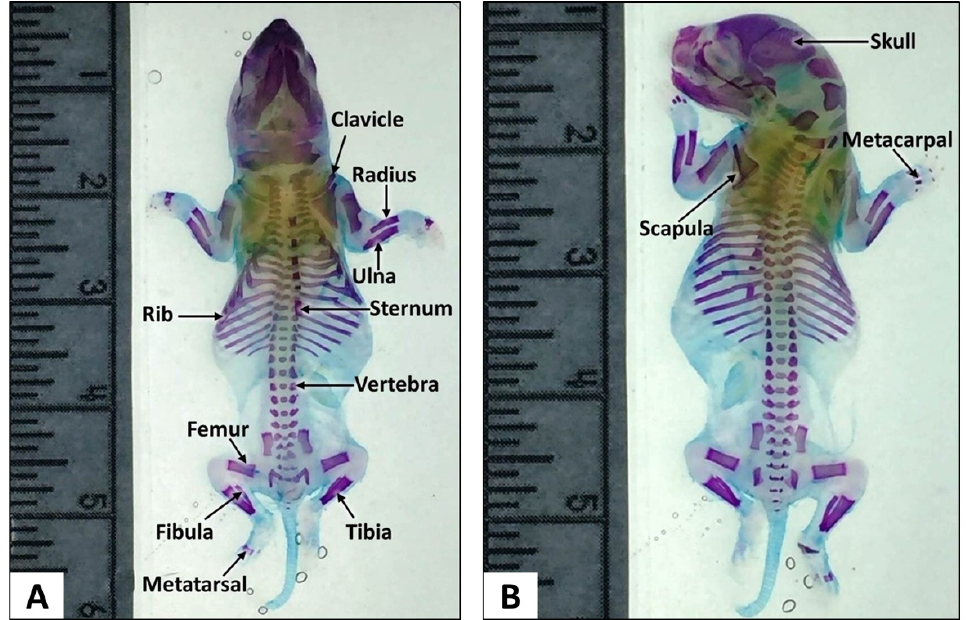
Figure 3. Normal skeleton of a full-term SD rat foetus stained using a modified double-staining technique for the skeletal system. Ventral ( A ) and Dorsal ( B ) views. (Scale is in cm). Table 2. Occurrence of skeletal abnormalities in the offspring of SD rats treated with different doses of AHAE.